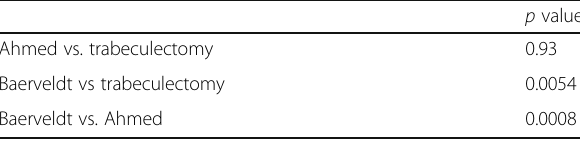
Table 6 Cumulative failure analysis